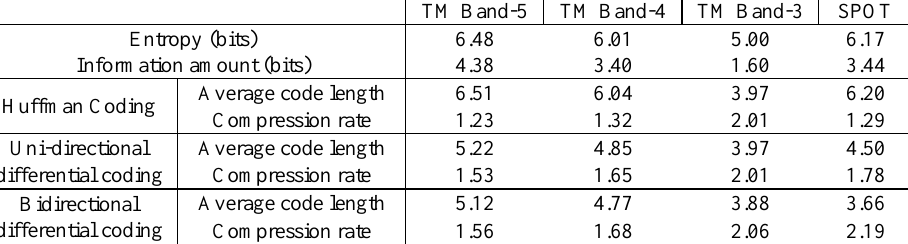
Table 2. Comparisons between Huffman coding and differential coding